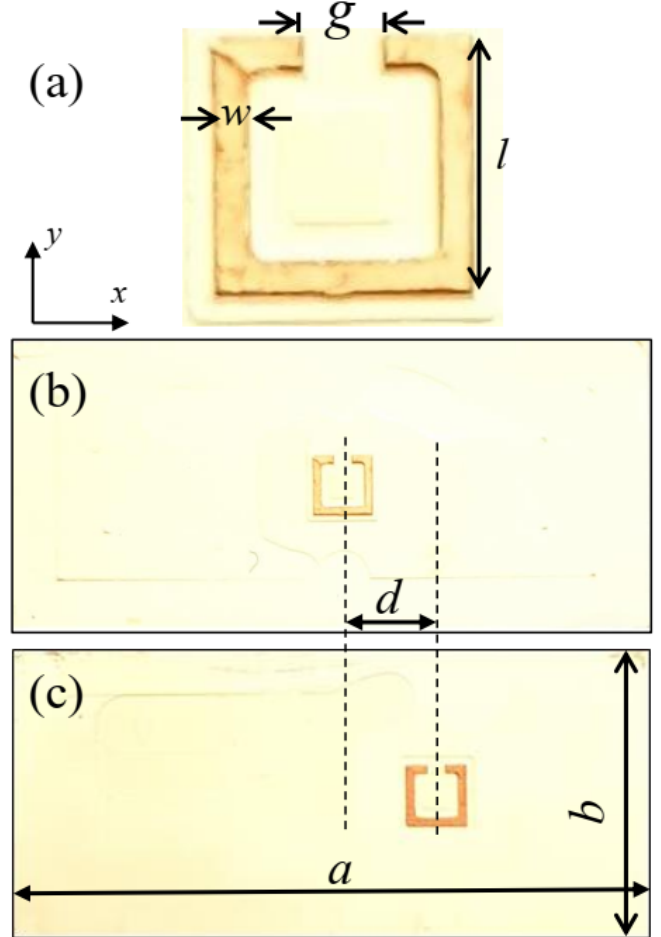
Figure 1. Photos of the fabricated samples. ( a ) A split ‐ ring resonator (SRR) with the important geometrical dimensions, ( b ) Symmetric configuration with the SRR structure in the middle of the waveguide, and ( c ) Asymmetric configuration with the SRR structure shifted by a distance d .